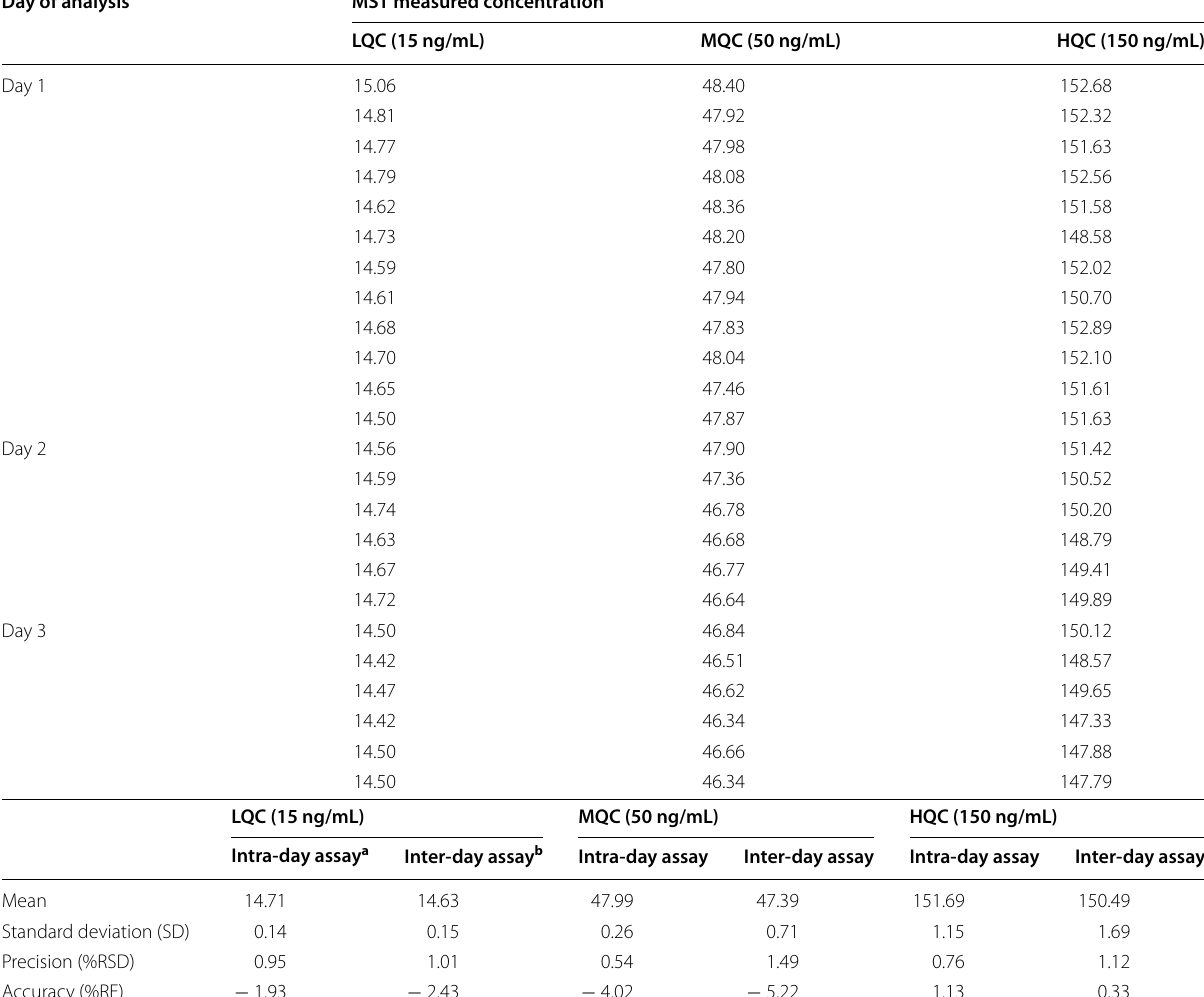
a Average of twelve determinations of day 1 b Average of six determinations in three consecutive